Question: Summarize what this figure shows in one sentence.
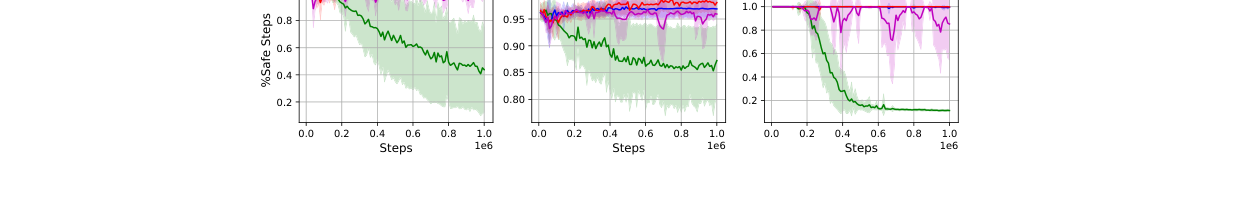
Answer: MuJoCo Results - Reward and Safety Performance